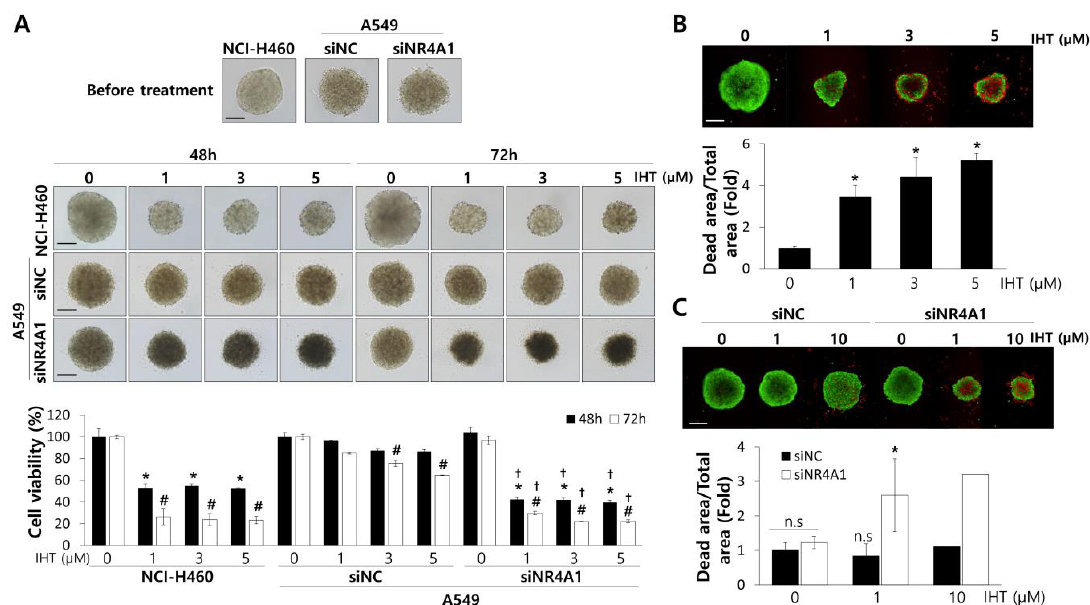
Figure 3. Treatment of IHT in NCI-H460 and with combination of IHT and nuclear receptor subfamily 4 group A member 1 (NR4A1) knockdown in A549 effectively repressed the growth of tumorspheroids and enhanced cell death. ( A ) Two days after ULA plating, NCI-H460 and siRNA-transfected A549 tumorspheroids were treated for 48 and 72 h with the indicated concentrations of IHT. Cell viability was measured by the CellTiter-Glo 3D cell viability assay. Scale bars, 200 μm. *, significantly different from control at 48 h ( p < 0.05); #, significantly different from control at 72 h ( p < 0.01); †, significantly different from siRNA for negative control (siNC) ( p < 0.01). NCI-H460 ( B ) and A549 ( C ) tumorspheroids were treated with IHT for 72 h. Live cells were stained green with calcein-acetoxymethyl ester (AM), while dead cells were stained red with ethidium homodimer-1 (EthD-1). Cell images were collected at a magnification of 100× using an Operetta High Content Screening (HCS) System. Scale bar: 200 μm. *, significantly different from control ( p < 0.05). All data are presented as mean ± SD.